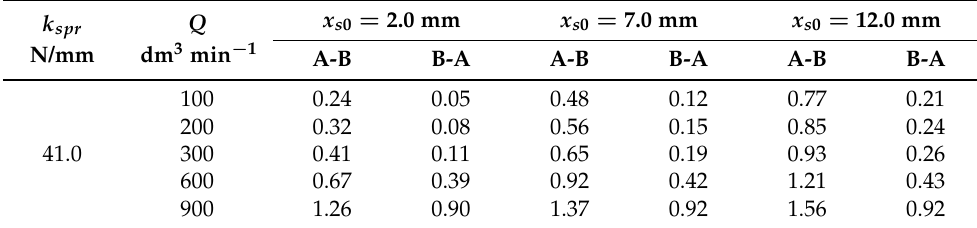
Figure 17. Pressure drop on check valve for different initial spring tension values: ( a ) reduced, ( b ) nominal, ( c ) increased; flow direction B-A. Table 6. Check valve pressure drop (MPa) against flow rate Q and initial tension x s 0